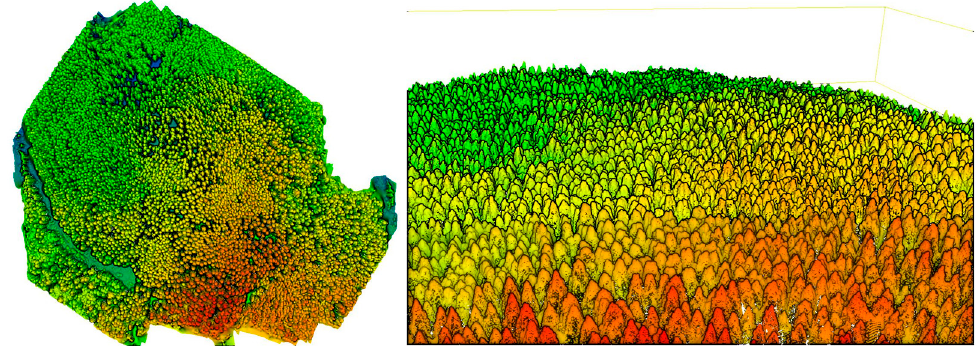
Figure 6. Nadir ( left ) and oblique ( right ) views of test site v02 RGB point cloud colored by height. Green indicates lower height and red indicates higher height. Nadir and oblique views.